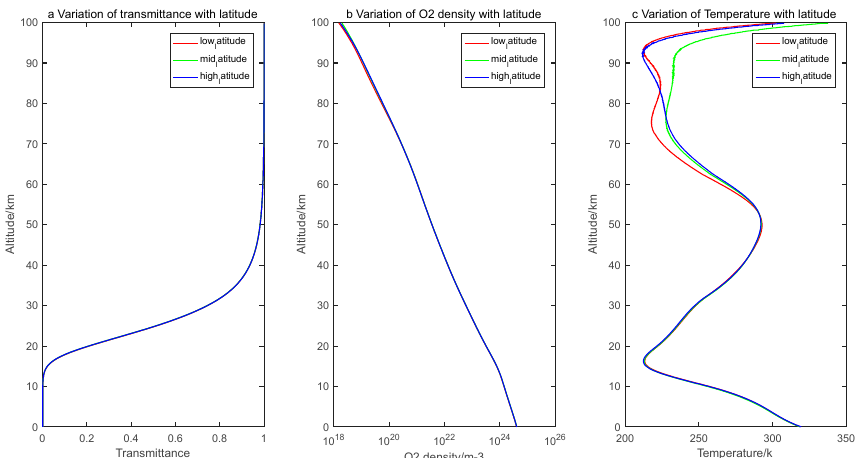
Figure 11. Inversion results of transmittance ( a ), oxygen number density ( b ), and temperature ( c ) at 757.84 nm at low latitude, middle latitude, and high latitude, respectively.